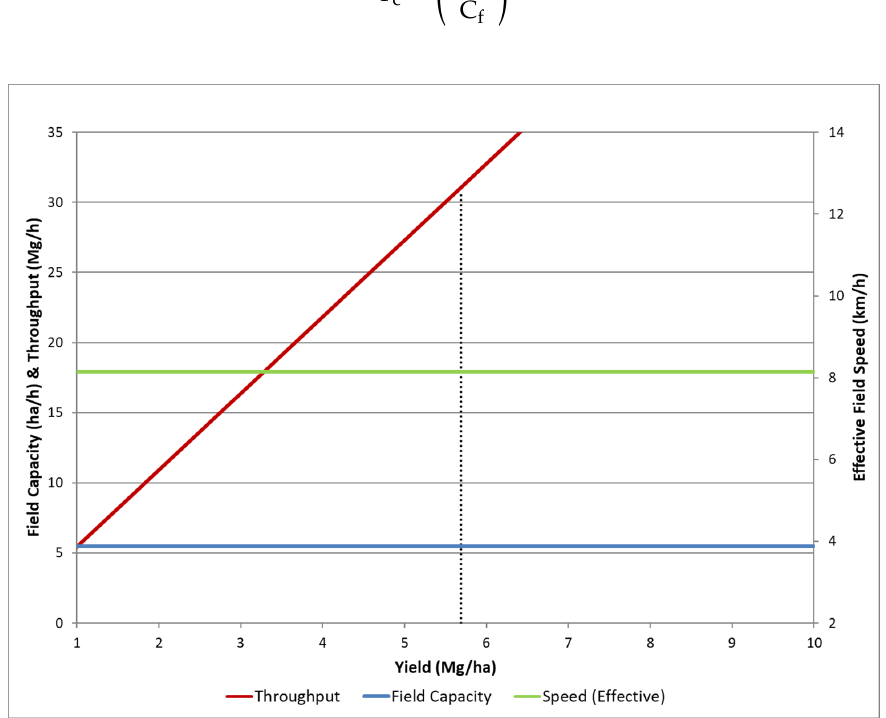
Figure 1. Results obtained by assuming that speed and capacity are constant for all yields. Equations (1), (2), and (4) are used assuming operating parameters: W = 6.7 m, v = 10.9 km/h, E f = 0.74, and Y c = 5.6 Mg/ha.